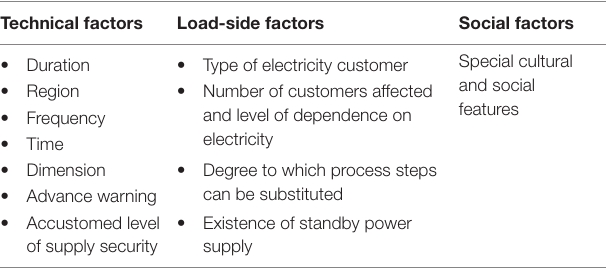
TABLe 1 | Factors influencing power